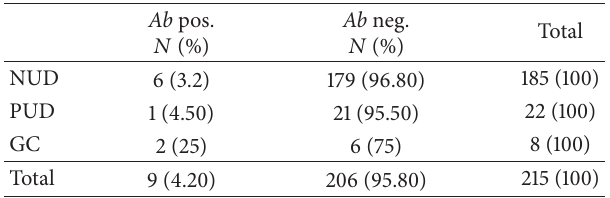
Table 7: Prevalence of Acinetobacter baumannii according to disease group.